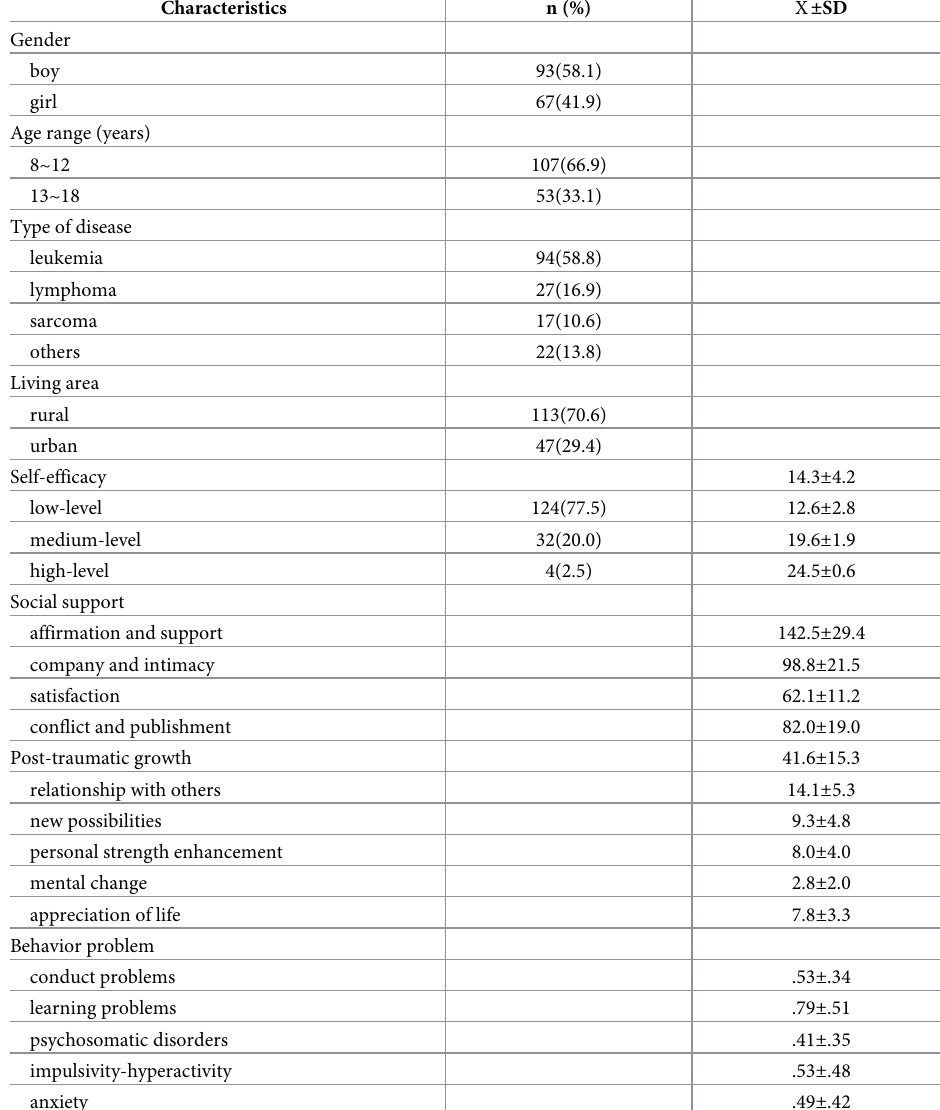
Table 1. Sample characteristics and behavior problems (N =